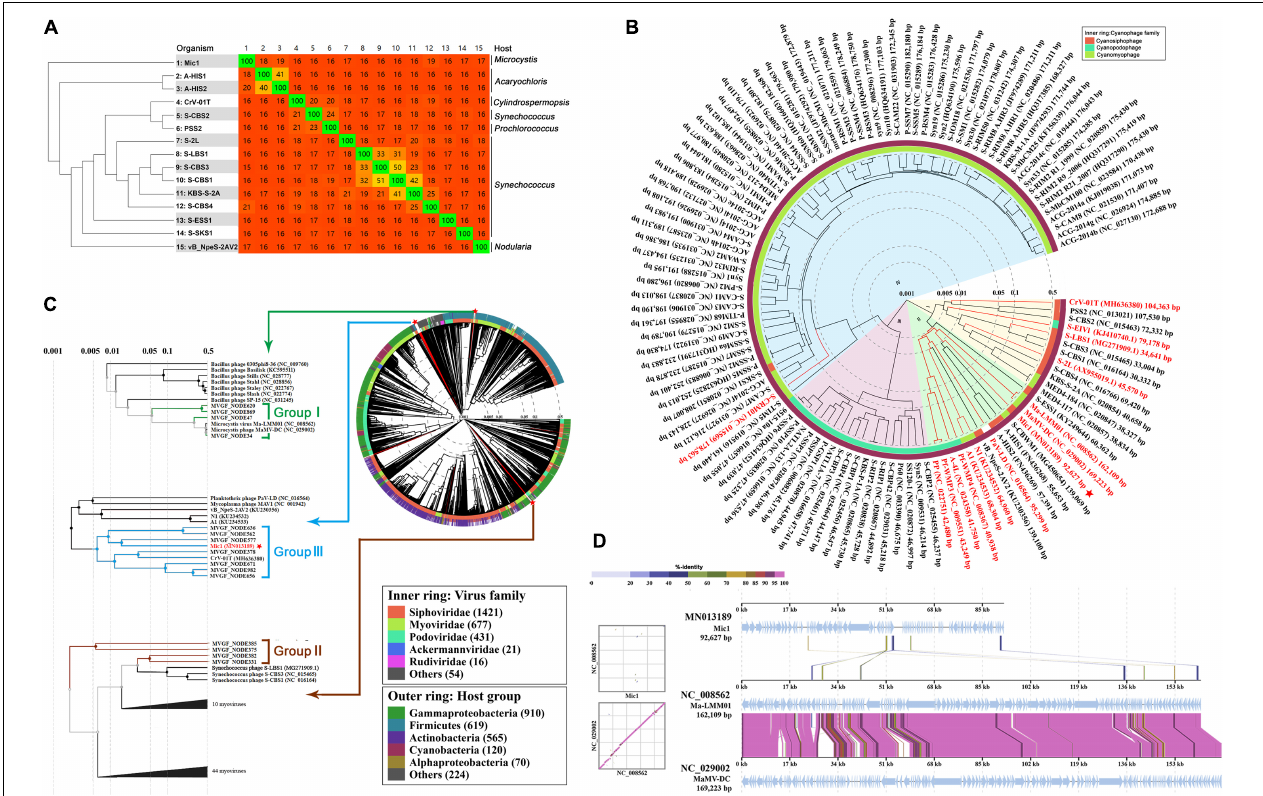
FIGURE 5 | The evolutionary analyses of Mic1. (A) Heatmap and phylogenomic tree analyses of cyanosiphophages. The heatmap was generated using Gegenees (tBLASTx method, accurate parameters-fragment length: 200 bp, step size: 100 bp). The numbers show the percentage similarity between the conserved regions of the genomes, whereas the colors reflect the similarity ranging from low (red) to high (green). The Splits Tree dendrogram at the left was calculated using the Nexus file exported from Gegenees. (B) The proteomic tree was constructed based on the complete genome sequences of 112 cyanophages. The genome sequences of 12 phages (Mic1, S-2L, S-LBS1, KBS-S-2A, S-EIVI, CrV-01T, A1, N1, S-CBWM1, S-ESSI, A-HIS1, and A-HIS2 were obtained from GenBank and added into ViPTree. The other 100 genome sequences were obtained from Virus-Host Database (https://www.genome.jp/virushostdb/). Cyanophages in the four clusters are shaded in different colors: (I) marine siphophages (yellow), (II) freshwater cyanophages (green), (II) marine podophages (pink), (IV) marine myophages (blue). The previously reported freshwater cyanophages are marked in red, and Mic1 is labeled with a red star. (C) Proteomic tree of the complete genome sequences of 2697 dsDNA phages and 15 Microcystis viral genomic fragments (MVGFs). Mic1 is labeled with a red star. The whole proteomic tree was generated by ViPTree server ver.1.9. Branch lengths were logarithmically scaled from the root of the entire proteomic tree. (D) Genome alignment of Mic1, Ma-LMM01, and MaMV-DC. All tBLASTx alignments are represented by colored lines between two genomes. Color scale represents the tBLASTx percent identity.